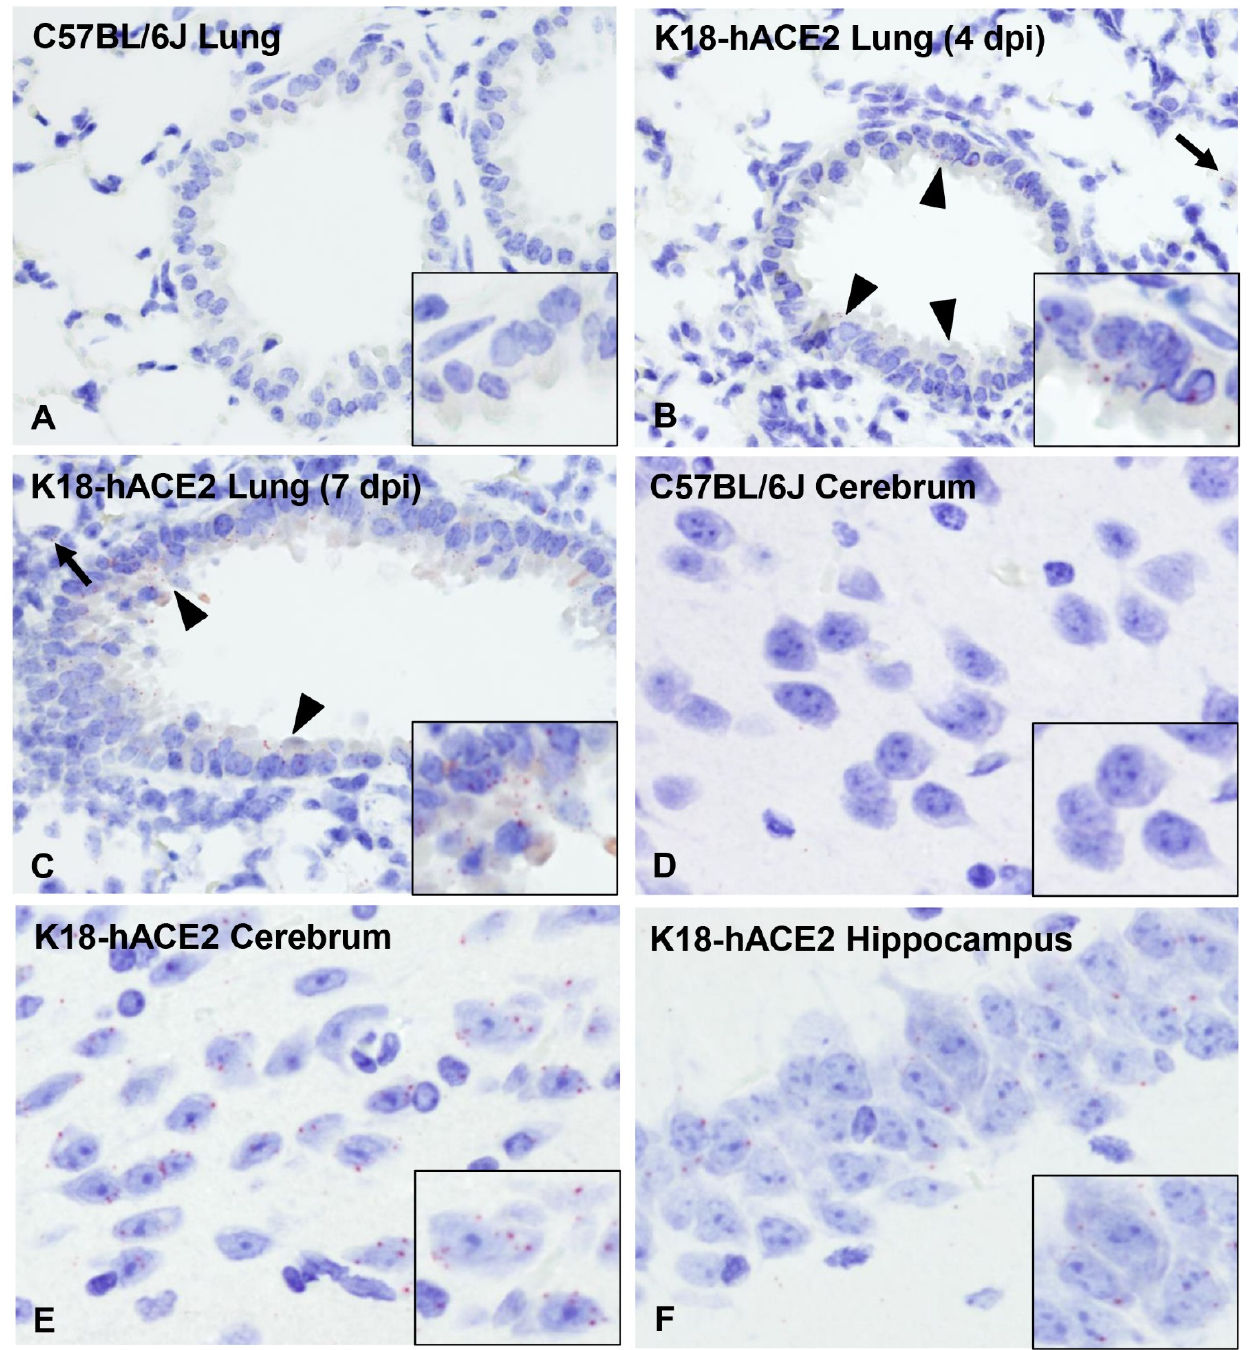
Figure 10. Expression and distribution of hACE2 mRNA in the brain and lungs of non-transgenic wild-type C57BL/6J and K18-hACE2 transgenic mice via RNAscope ® ISH. ( A – C ) hACE2 lung expression. While no expression of hACE2 was noted in the lungs of wild-type C57BL/6J mice ( A ), hACE2 was expressed in the bronchiolar epithelium (arrowheads) and sporadic AT2 cells (arrows) in transgenic K18-hACE2 mice ( B , C ), which correlated with immunohistochemical findings. ( D – F ) hACE2 brain expression. hACE2 was not expressed in the Cerebrum of C57BL/6J mice ( D ) but in clusters of neurons within the cerebrum ( E ) and hippocampus ( F ). Fast Red, 400 × total magnification. Bar = 50 µ m. 3.8. Absence of Infection and Histologic Lesions in Extrapulmonary and Extraneural Tissues In the brain of both non-transgenic WT C57BL/6J and K18-hACE2 mice, ACE2 protein despite ACE2 Expression was observed in blood vessels (Figure 9J–L), as well as ependymal and choroid